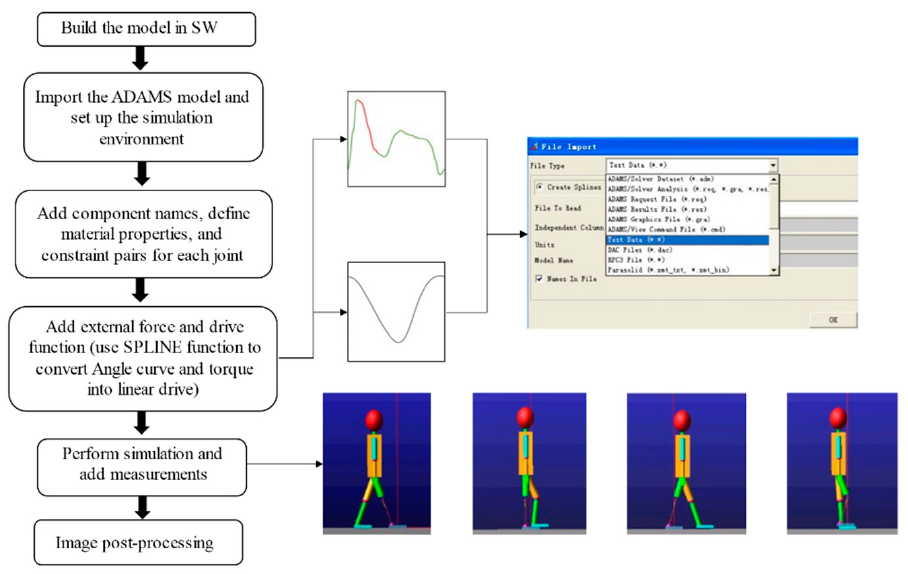
Figure 9. The torque simulation process in the ADAMS. Table 2. Human body parameters setting in ADAMS.